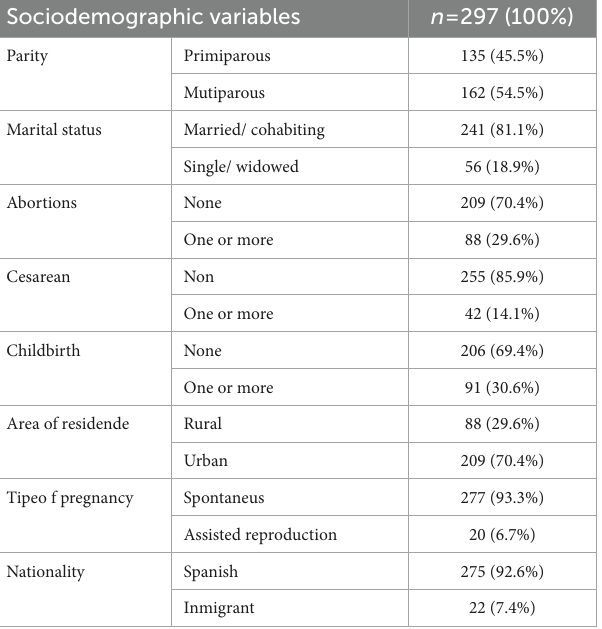
TABLE 1 Sociodemographic and obstetric characteristics of the woman in the study. Sociodemographic variables